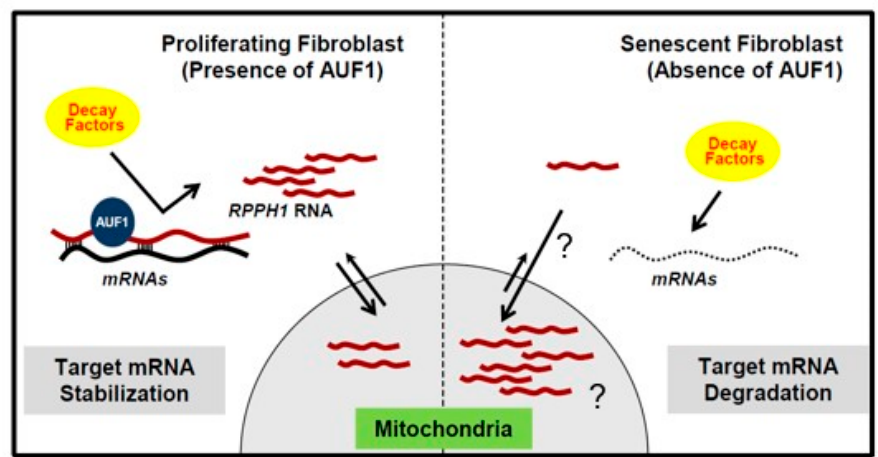
Figure 6. A proposed model of RPPH1 RNA function on target mRNAs’ destabilization during cellular senescence. With RPPH1 localized in the mitochondria during senescence, target mRNAs’ association with RPPH1 is lowered, and thus they are more subject to cytoplasmic decay. AUF1 facilitates the cytoplasmic retention of RPPH1 RNA, however it is unknown how AUF1-free RPPH1 RNA move to the mitochondria. The mitochondrial accumulated RPPH1 might possess other unknown function beyond target mRNA protection which also contribute to cellular senescence.